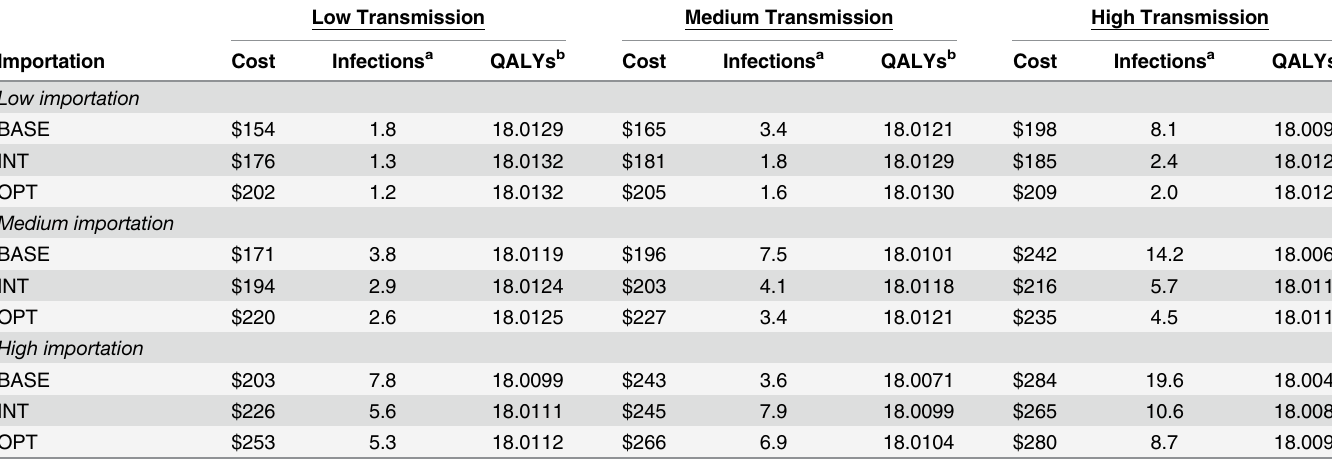
Table 3. Mean cost, QALYs, and infections per 10,000 patient days by BASE, INT, and OPT.